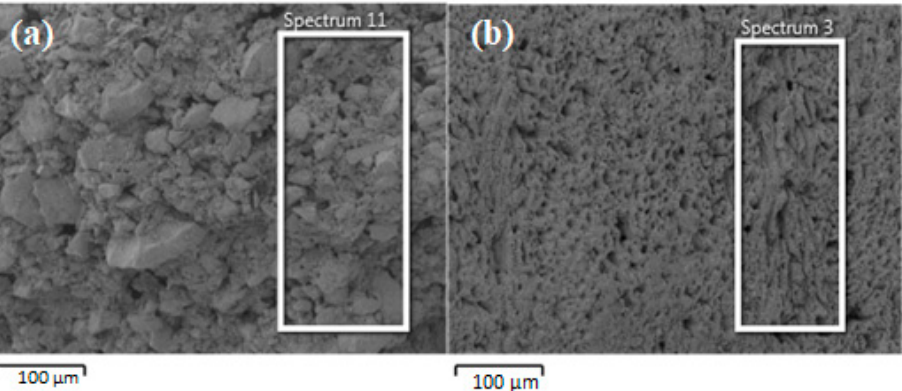
Figure 1. Scanning electron microscope (SEM) image of granular activated carbon conditioned with deionized water (GAC) ( a ) and with hydrochloric acid (GACA) ( b ). Table 1. Energy-dispersive X-ray (EDX) spectroscopy analysis of GAC and GACA. GAC GAC-A Element Apparent Concentration wt.%